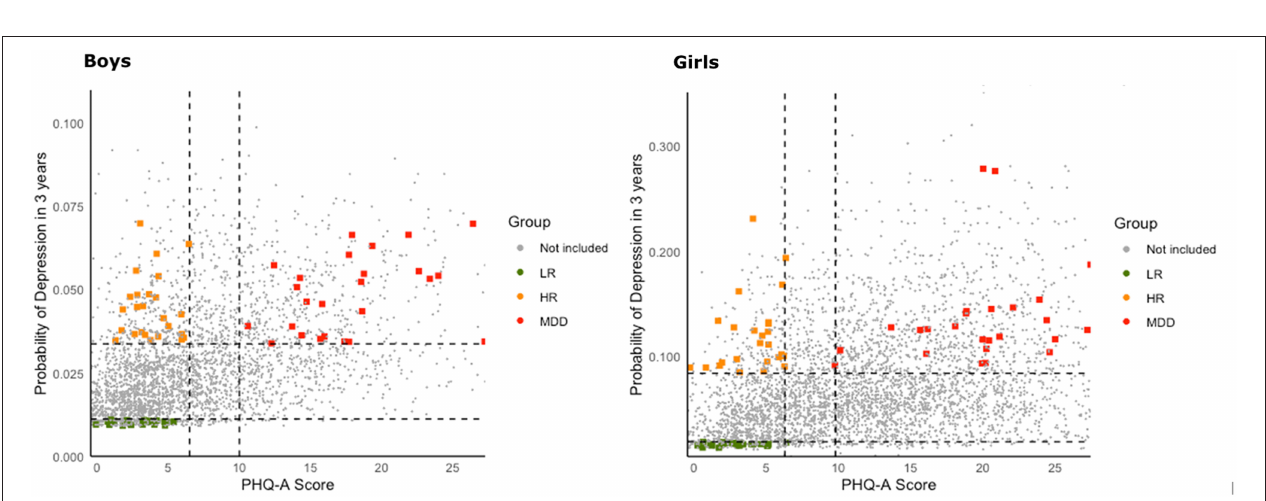
FIGURE 7 | Adolescents screened at schools and included in the Identifying Depression Early in Adolescence Risk Stratified Cohort (IDEA-RiSCo). Vertical dotted lines show the Patient Health Questionnaire—adolescent version (PHQ-A) cutoffs, and horizontal dotted lines show the Identifying Depression Early in Adolescence risk score (IDEA-RS) cutoffs. Low risk (LR) adolescents appear in the lower left quadrant (PHQ-A ≤ 6 and IDEA-RS ≤ 20th percentile); high risk (HR) adolescents in the upper left quadrant (PHQ-A ≤ 6 and IDEA-RS ≥ 90th percentile); and adolescents with current major depressive disorder (MDD), in the upper right quadrant (PHQ-A ≥ 10 and IDEA-RS ≥ 90th percentile). Gray dots representing the students who did not meet inclusion criteria are spread over all